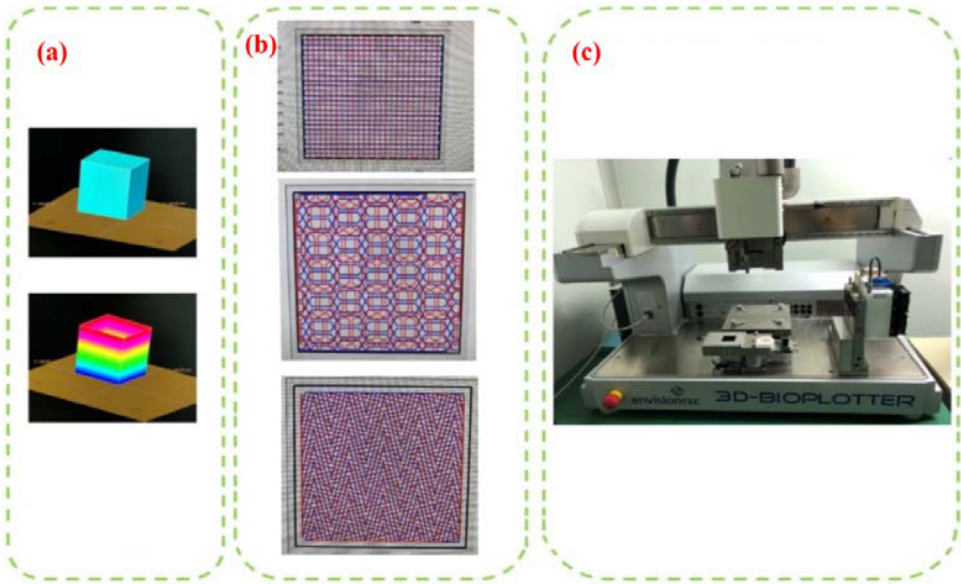
Figure 2. 3D model pre-processing: ( a ) Slice processing; ( b ) Internal structure selection; ( c ) 3D-bio-